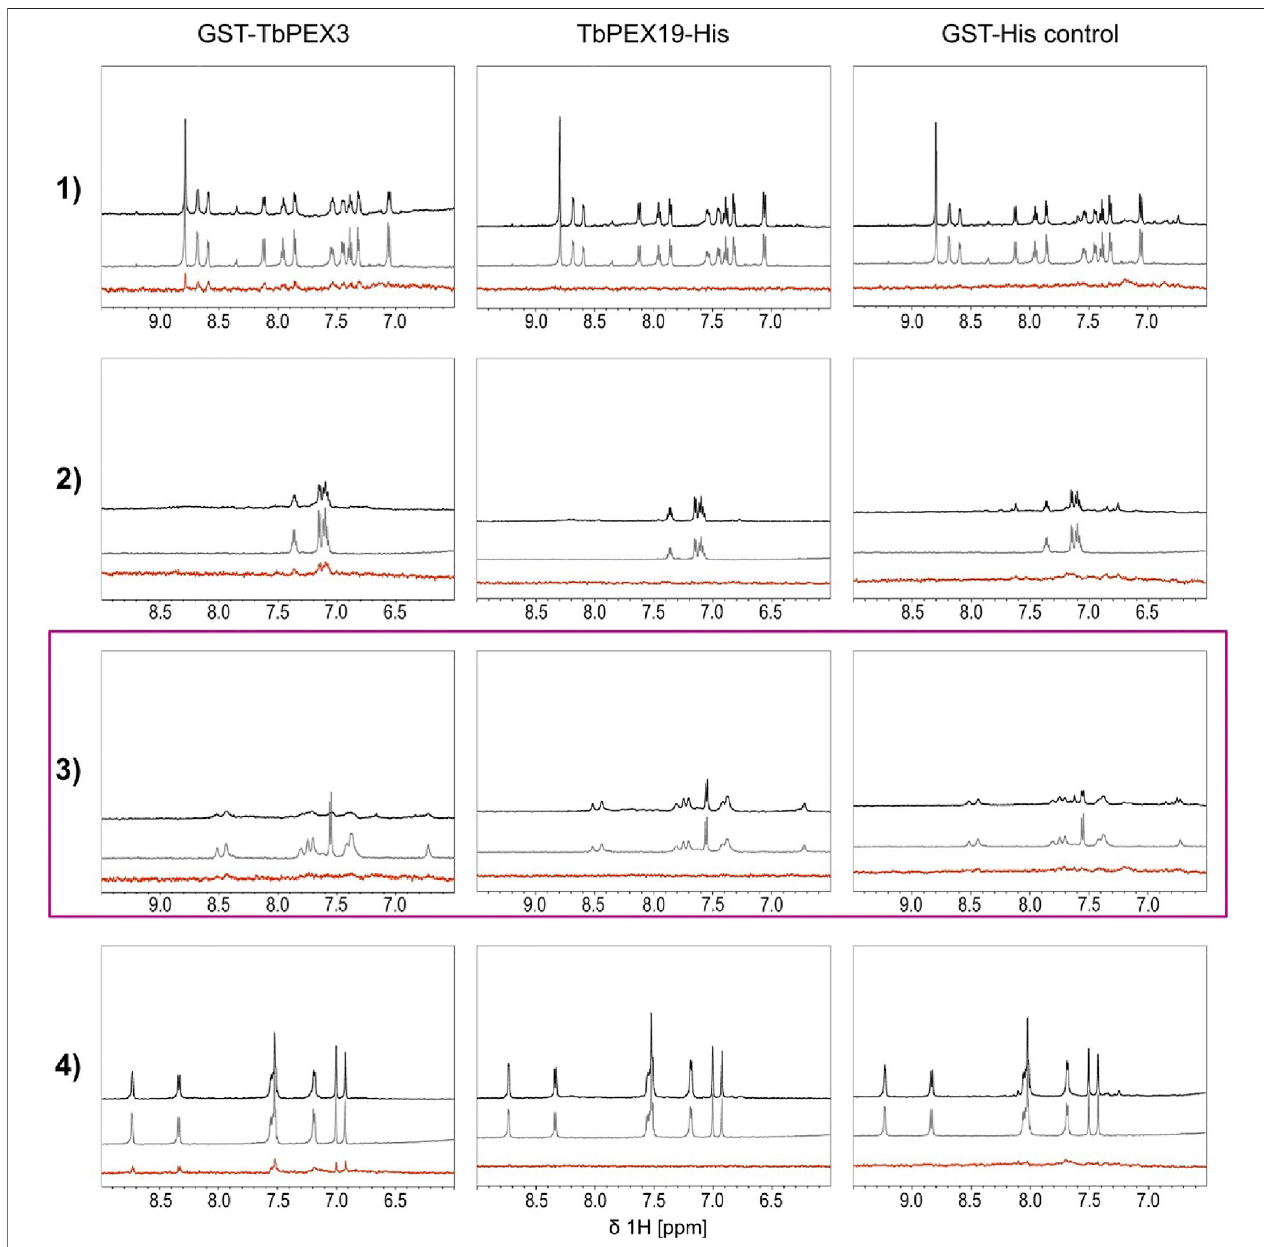
FIGURE 4 | Saturation transfer difference (STD) NMR experiments . STD experiments were carried out with the compounds 1 to 4 and the targets GST-TbPEX3 (left panels) , TbPEX19-His (middle panels) , and as aGST-His control (right panels) . 1D spectra of compound in the presence and absence of protein are shown on black and gray, respectively. STD difference spectra ofthe compound in the presence ofprotein are shown in red. Compounds 1 , 2 , and 4 show strong STD signal with GST-TbPEX3butnotwithTbPEX19orGSTrepresentinggoodbindingtowardTbPEX3.Compound 3 showsstrongline-broadeningwithGST-TbPEX3,andweak line-broadening when measured with the GST-His